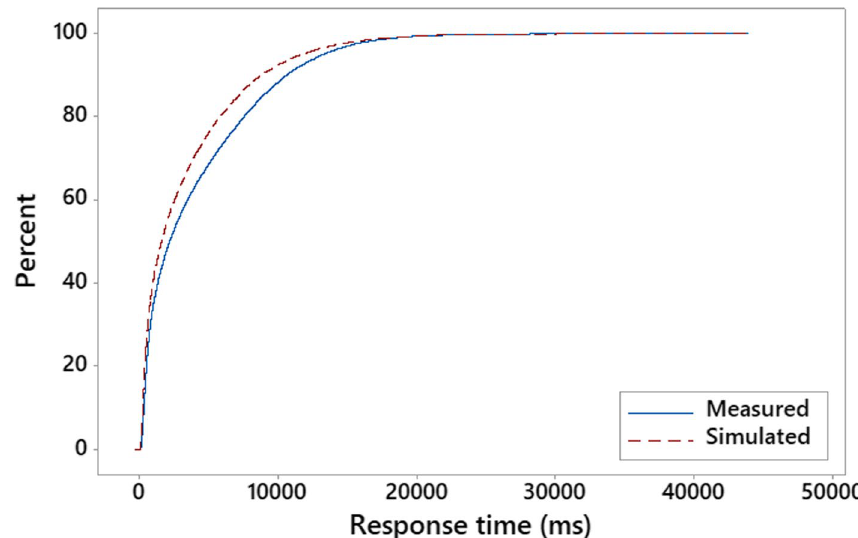
Fig. 8 ECDF plot of measured and simulated values of response time for burst validation scenario, MRS service, large instance